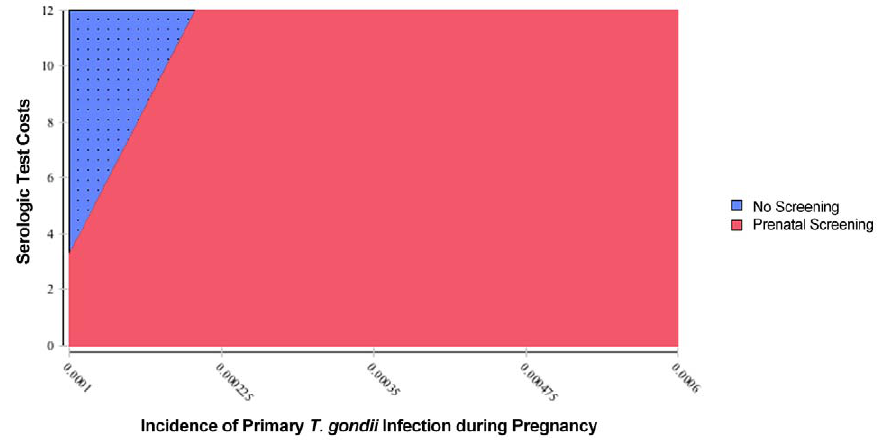
Figure 10. Two-way sensitivity analysis on incidence of primary T.gondii infection during pregnancy and serologic test costs (detail).